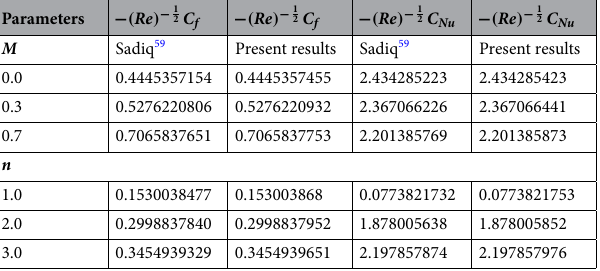
Table 3. Comparative assessment of published results with the current